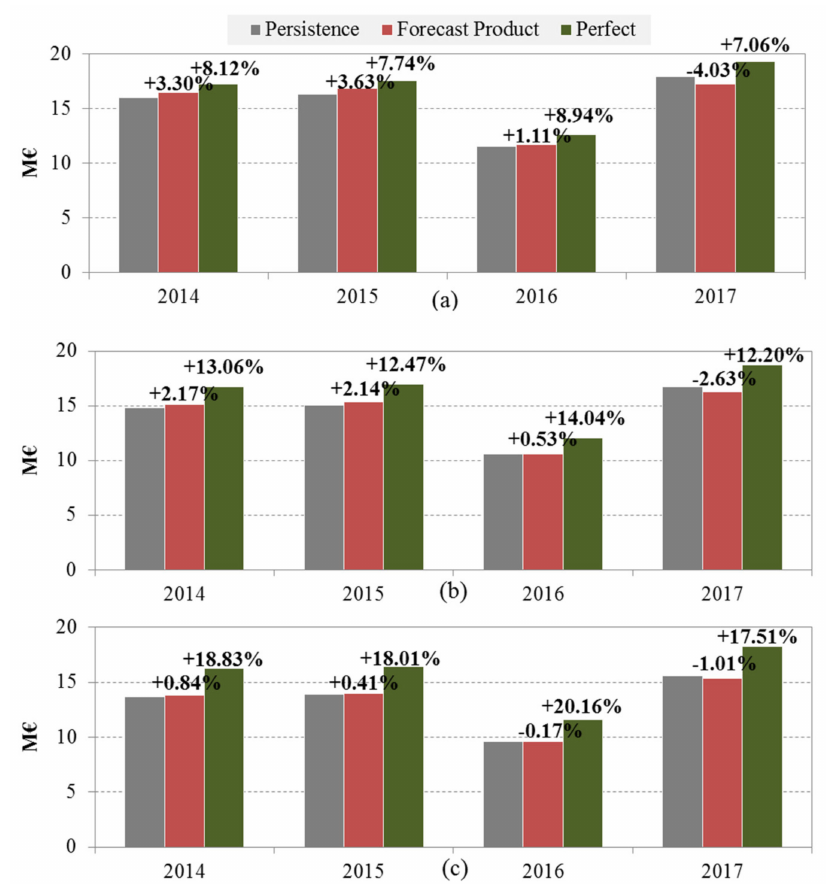
Figure 12. Annual financial income based on the optimized dispatching strategy without the UPP application, considering 0% ( a ), 50% ( b ) and 100% ( c ) penalty of the market price when scheduled electricity is not delivered. Persistence, perfect and product forecasts are considered as input. The rate of improvement with reference to the persistence forecast case is